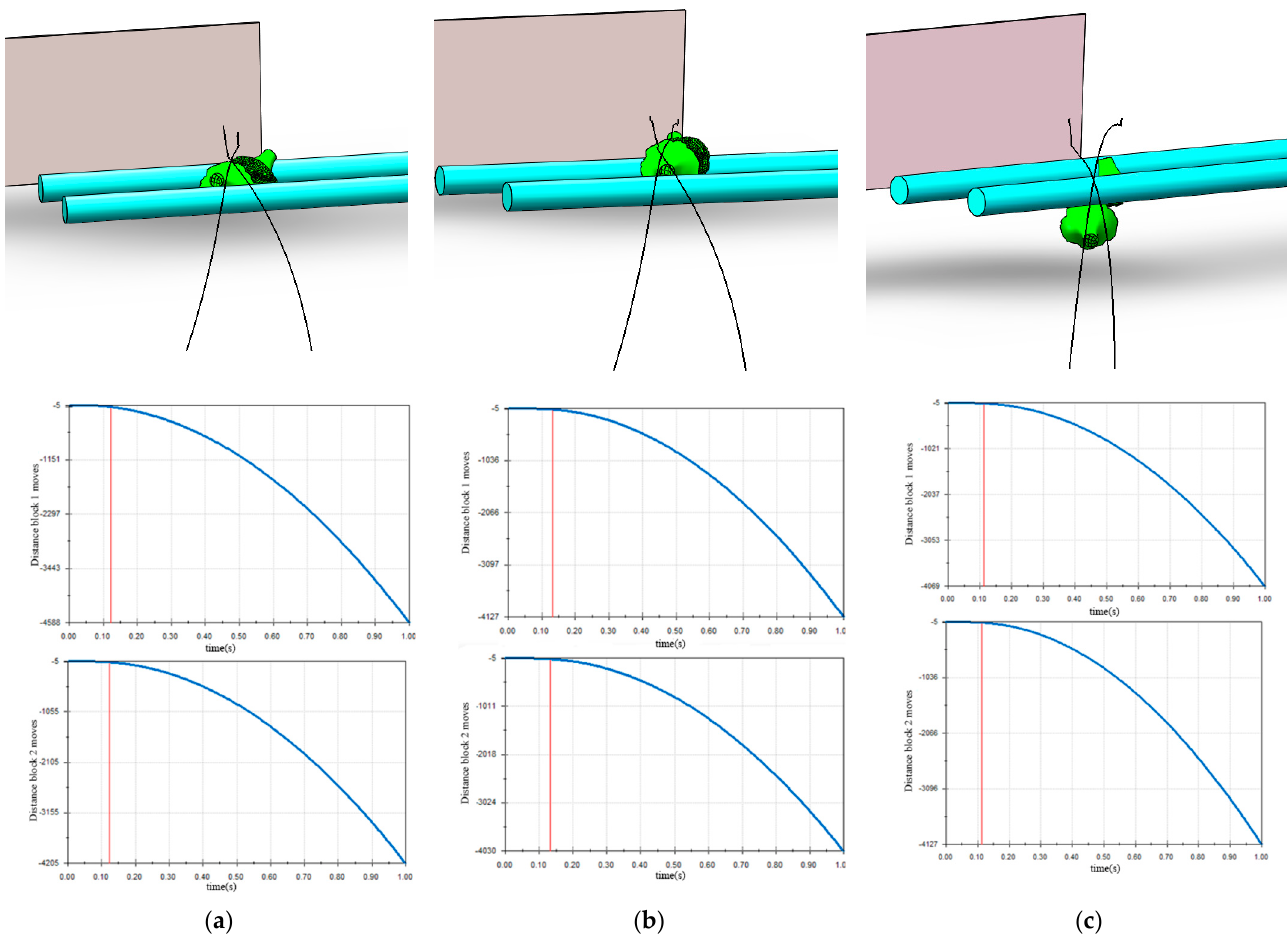
Figure 7. The small block staggered screening simulation analysis charts, respectively, the trajectory of two blocks and the distance and separation time of the center of mass of the two blocks moving in the direction of gravity: ( a – c ) correspond to 300:400, 300:500, and 300;600, respectively. From the simulation results analysis of small blocks staggering, in the three-speed groups, the differential circular belt can realize the blocks screening so that the small blocks fall from the gap between the two circular belts. The screening times of the three- speed groups are 300:600 mm/s, 300:500 mm/s, and 300:400 mm/s, corresponding to 0.11 s, 0.13 s, and 0.14 s, respectively, and the speed combination of 300 mm/s and 600 mm/s has the shortest screening time, which is most suitable for the screening of blocks in the case of staggering small blocks. As shown in Figure 8 for the large and small block stacking screening simulation analysis charts, respectively, the trajectory diagram of the two blocks are simulated as well as the center of mass of the two blocks in the direction of gravity to move distance and stagger time. ( a )